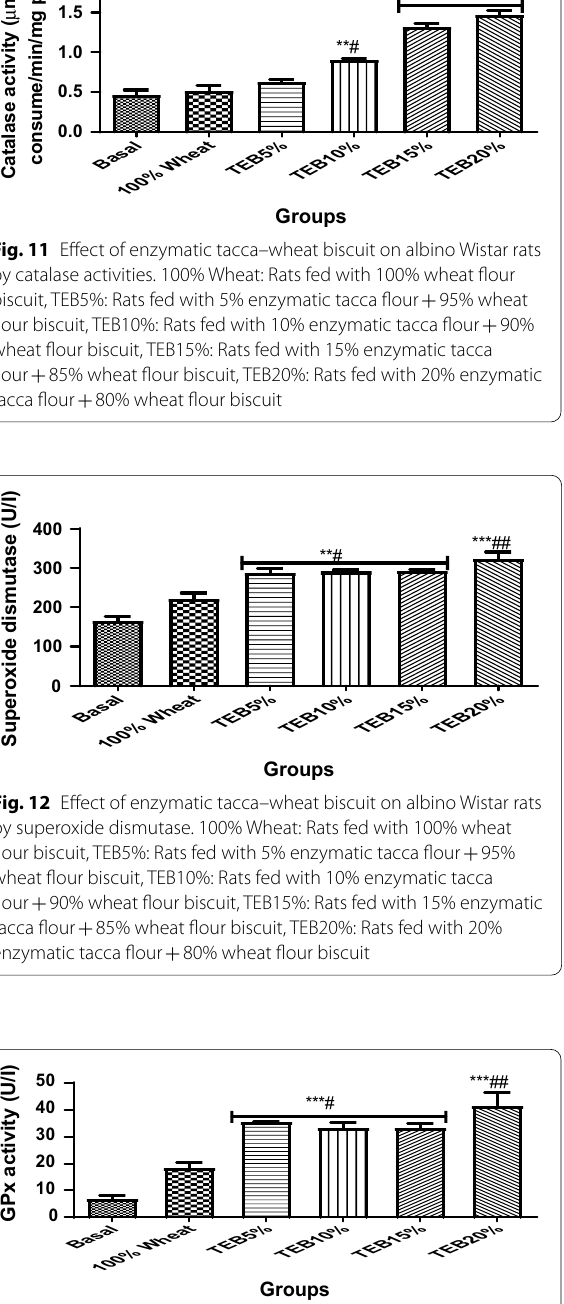
Fig. 13 Effect of enzymatic tacca–wheat biscuit on albino Wistar rats by glutathione peroxidase (GPx). 100% Wheat: Rats fed with 100% wheat flour biscuit, TEB5%: Rats fed with 5% enzymatic tacca flour 95% wheat flour biscuit, TEB10%: Rats fed with 10% enzymatic + tacca flour 90% wheat flour biscuit, TEB15%: Rats fed with 15% + enzymatic tacca flour 85% wheat flour biscuit, TEB20%: Rats fed + with 20% enzymatic tacca flour